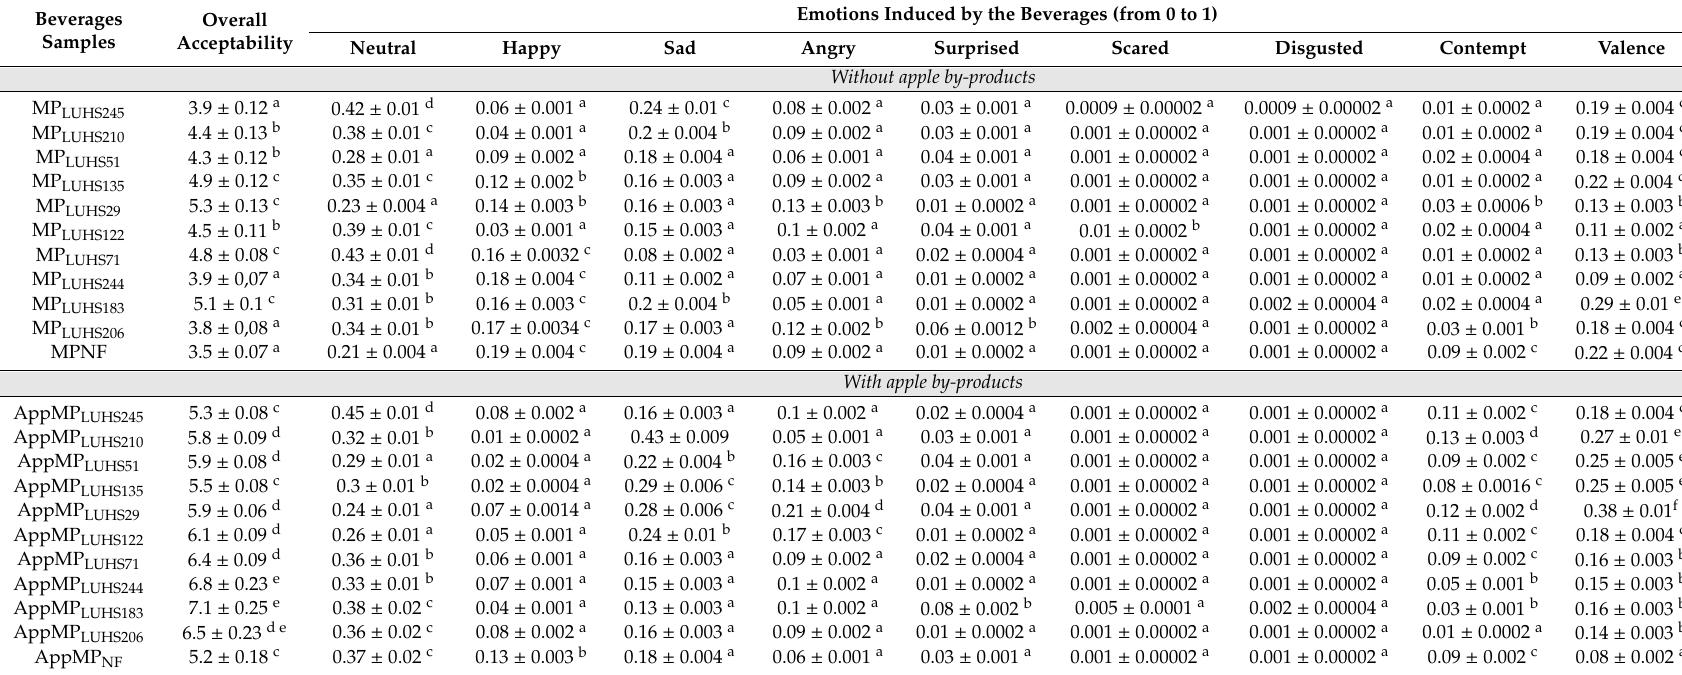
Table 4. Average values and standard deviations (Mean ± STDV) ( n = 3) of the overall acceptability and emotions induced by the milk permeate (MP) (0 h) and final fermented beverages (24 h), without and with addition of apple